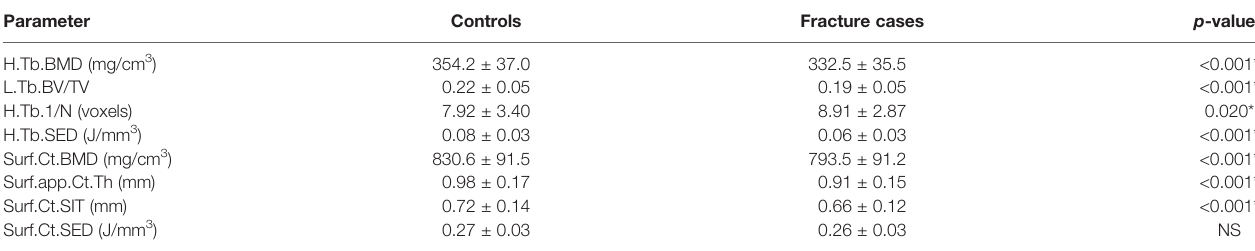
TABLE 4 | Homogenized and local trabecular voxel-based parameters, and cortical surface-based parameters with no spatial normalization.